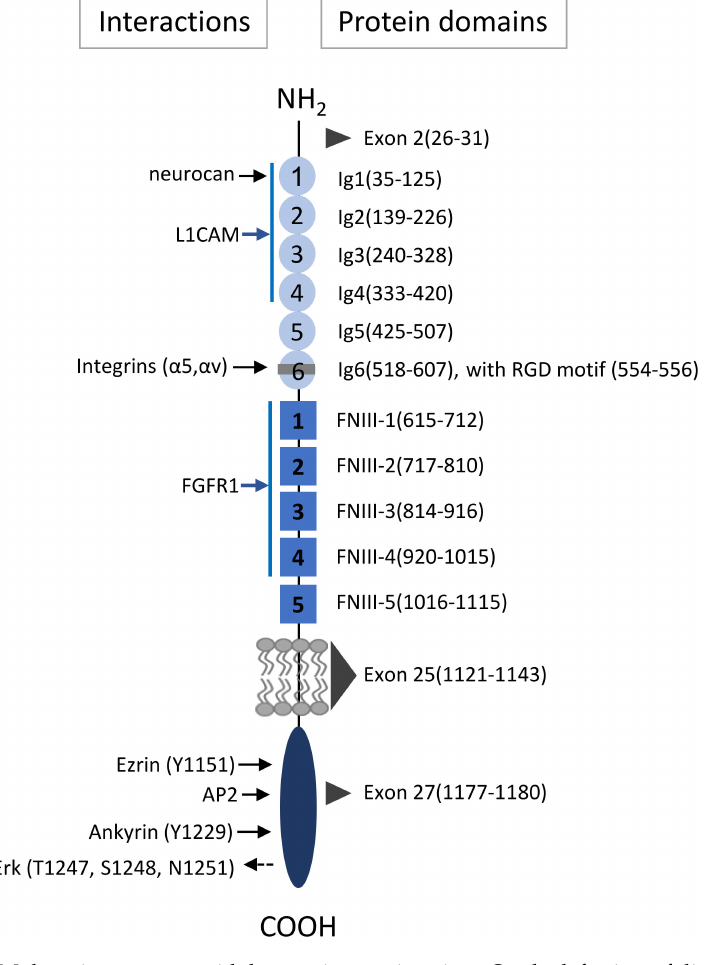
Figure 1. L1CAM domain structure with known interaction sites. On the left, sites of direct interaction are indicated with solid black right-pointing arrows, and possible indirect activation with dashed left-pointing arrow. Arrows in blue indicate interactions that span several Ig (immunoglobulin like)- or FNIII (fibronectin type III) repeats. On the right, numbered amino acid residues, corresponding with di ff erent domains or repeats are indicated. The black triangles indicate the amino acid sequences encoded by alternatively spliced exons 2, 25 and